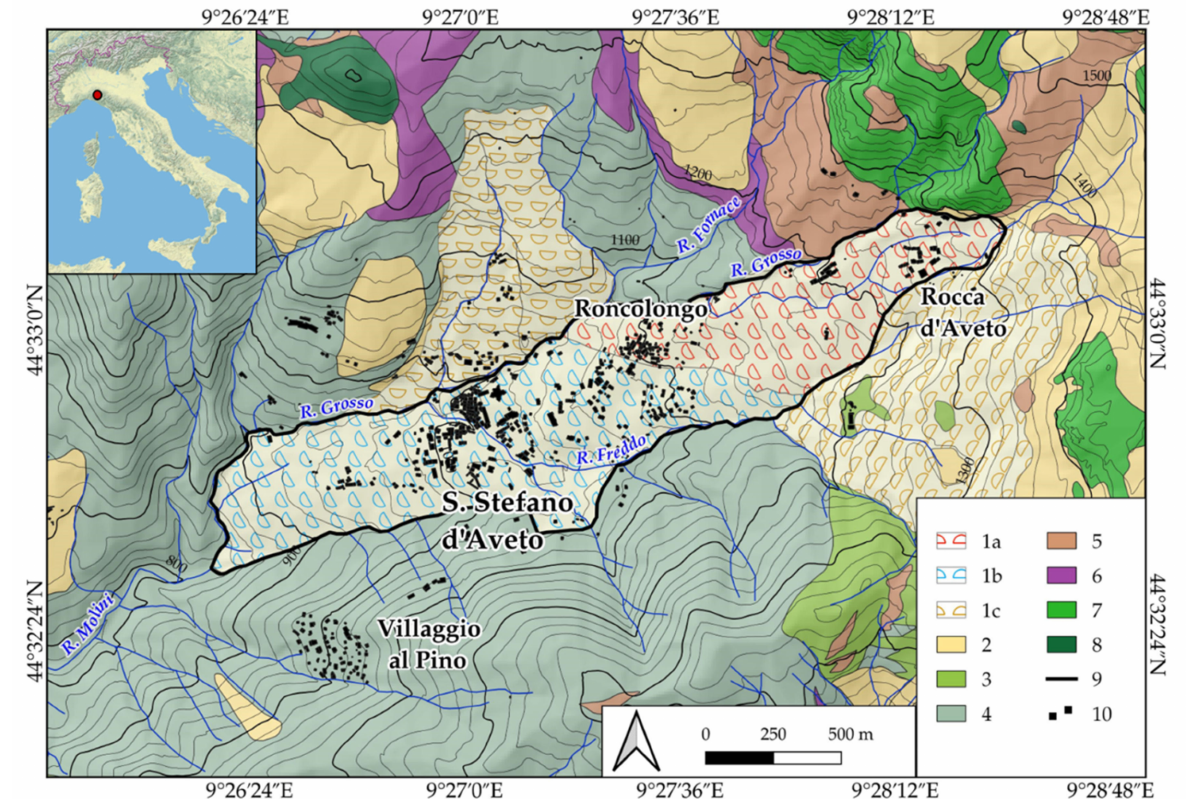
Figure 2. Geological sketch map of the area of the Santo Stefano d’Aveto landslide (red dot in the upper image), modified from [24]: (1a) Active landslide; (1b) Inactive landslide; (1c) Undifferenti- ated landslide deposits; (2) Other quaternary deposits: slope deposits, alluvial deposits, lacustrine deposits; (3) Shales; (4) Marly limestone flysch; (5) Sandstones; (6) Polygenic breccias; (7) Basalts; (8) Serpentinites; (9) Perimeter of the Santo Stefano landslide; (10) Buildings. Landslide activity according to IFFI